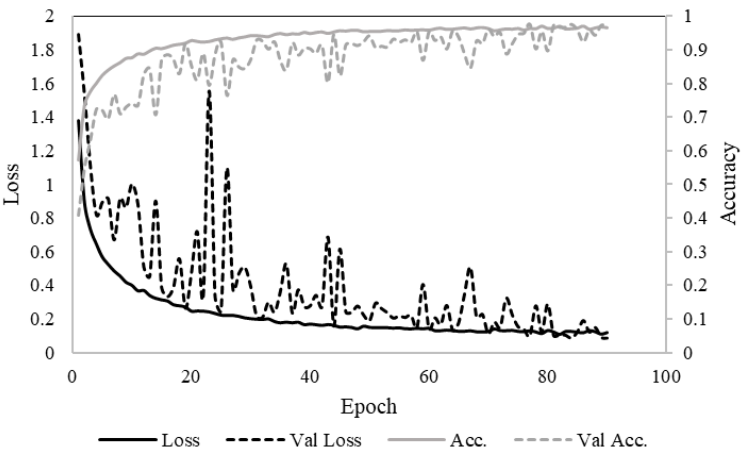
Figure 4. Averaged training and validation parameters for five folds. Val Loss: Validation Loss; Acc.: Accuracy; Val Acc.: Validation Accuracy.